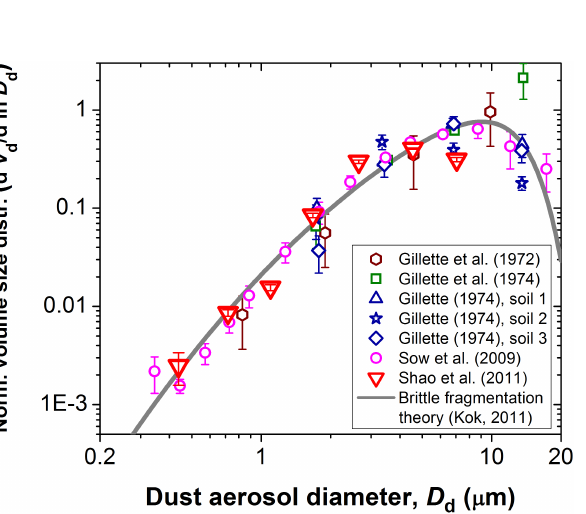
Fig. 1. Field measurements with standard error of the volume size distribution of emitted dust aerosols (assorted symbols), processed as described in Kok (2011). The brittle fragmentation theory of dust emission (solid line) (Kok, 2011) is in good agreement with these measurements, including the subsequently published Shao et al. (2011) (large triangles; note that Shao et al. (2011) questioned the reliability of their 0.3–0.6µm particle size